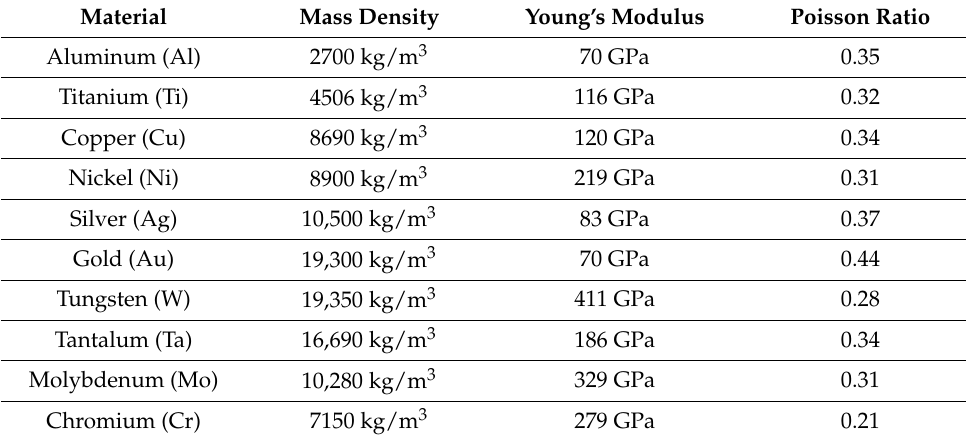
Table 3. Properties of different metallic MEMS materials.